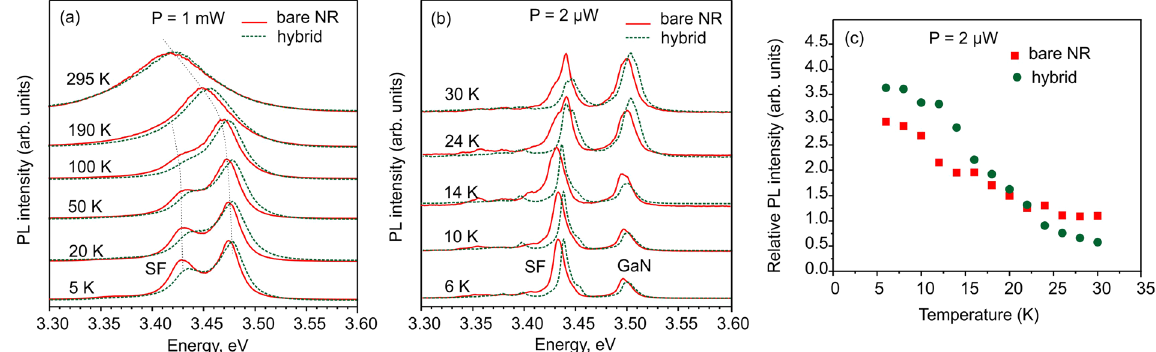
Figure 2. Temperature dependent PL spectra measured at excitation power of 1 mW ( a ) and 2 µ W ( b ). Spectra are normalized and shifted vertically for clarity. Spectra taken for as-grown GaN NRs (bare NR) are shown by solid red lines, for NRs covered by polyfluorene – by green dashed lines. ( c ) Temperature dependent ratio of the 3.43 eV peak intensity to the intensity of the DBE line (i.e. relative intensity) measured at excitation power of 2 µ W.